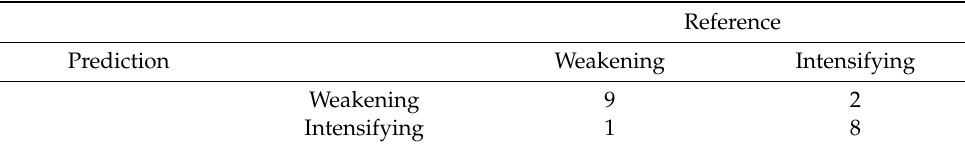
Table 6. Confusion matrix for the testing dataset produced from the LOOCV with ROSE sampling random forest with members trained using binary classes for island